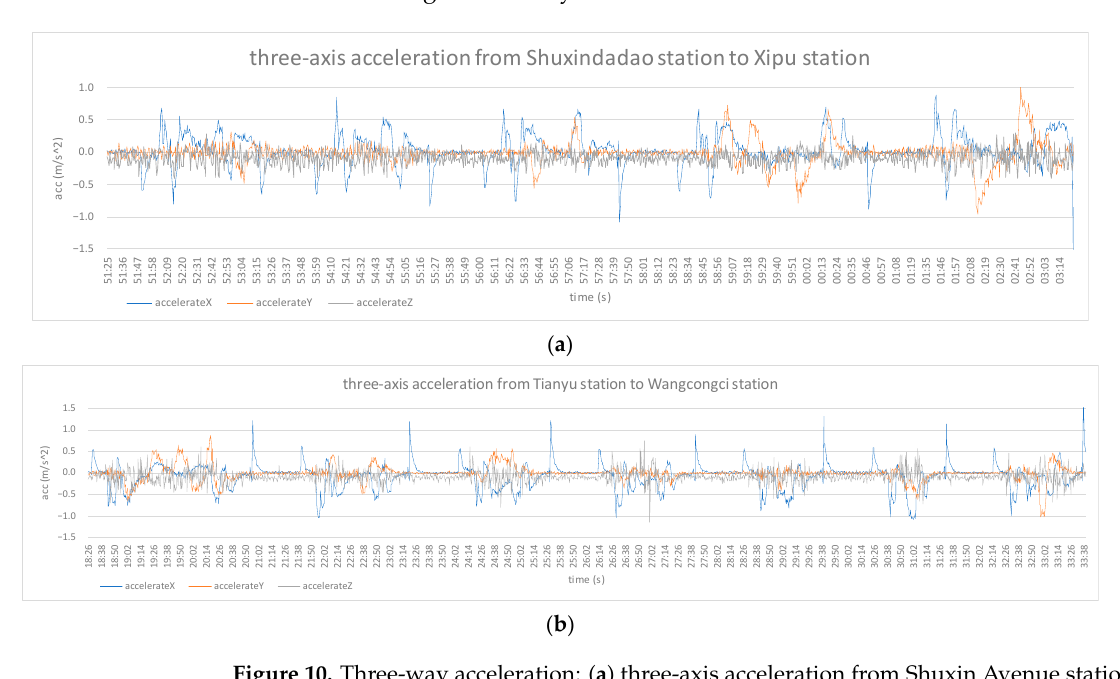
Figure 9. Application site of vibration measurement: ( a ) the mobile phone placed on the seat; ( b ) the mobile phone placed on the floor. The measurement time of the standing posture vibration measurement process was 12 min; the measurement time of the sitting posture vibration measurement process was 15 min. Its three-axis acceleration curve is shown in Figure 10. The acceleration fluctuations of the two states were similar. In the subway operation stage, the acceleration fluctuations of the three axes were obvious, and they were all in the range of − 0.5~0.5 m/s 2 . When the subway stopped and started, the x-axis acceleration increased sharply, and the maximum value reached 1.5 m/s 2 . During the stop phase of the subway, the three-direction acceleration changed smoothly.